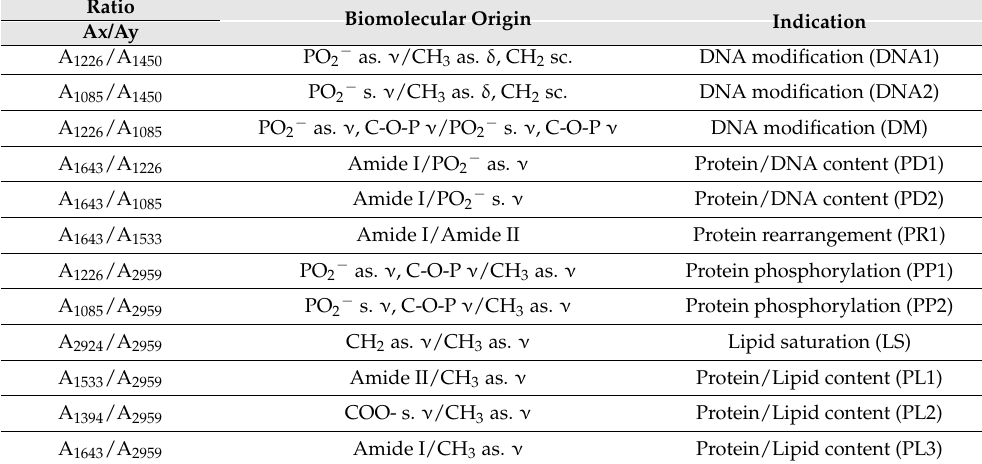
Table 1. A x /A y indicates the ratio between the areas of selected bands ([28] and references therein); abbreviations: as = asymmetric; s = symmetric; ν = stretching; δ = bending; sc = scissoring.